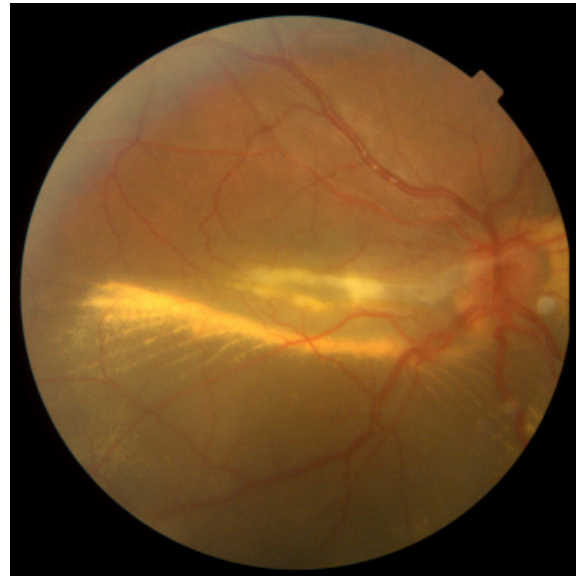
Figure 1: Posterior pole of right eye with subretinal exudation which involved macula with premacular membrane